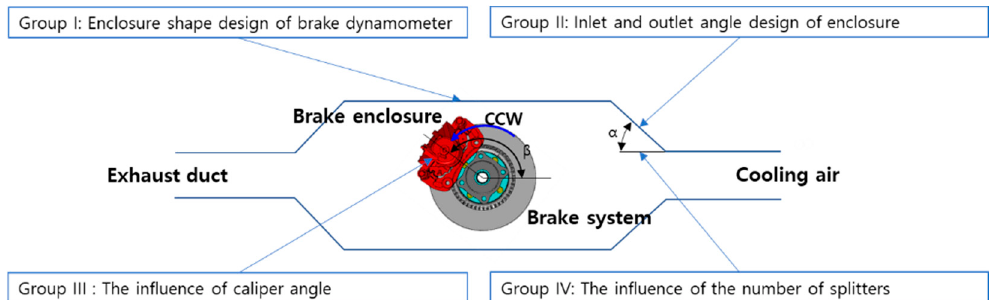
Figure 2. Schematic diagram of brake dust dynamometer.